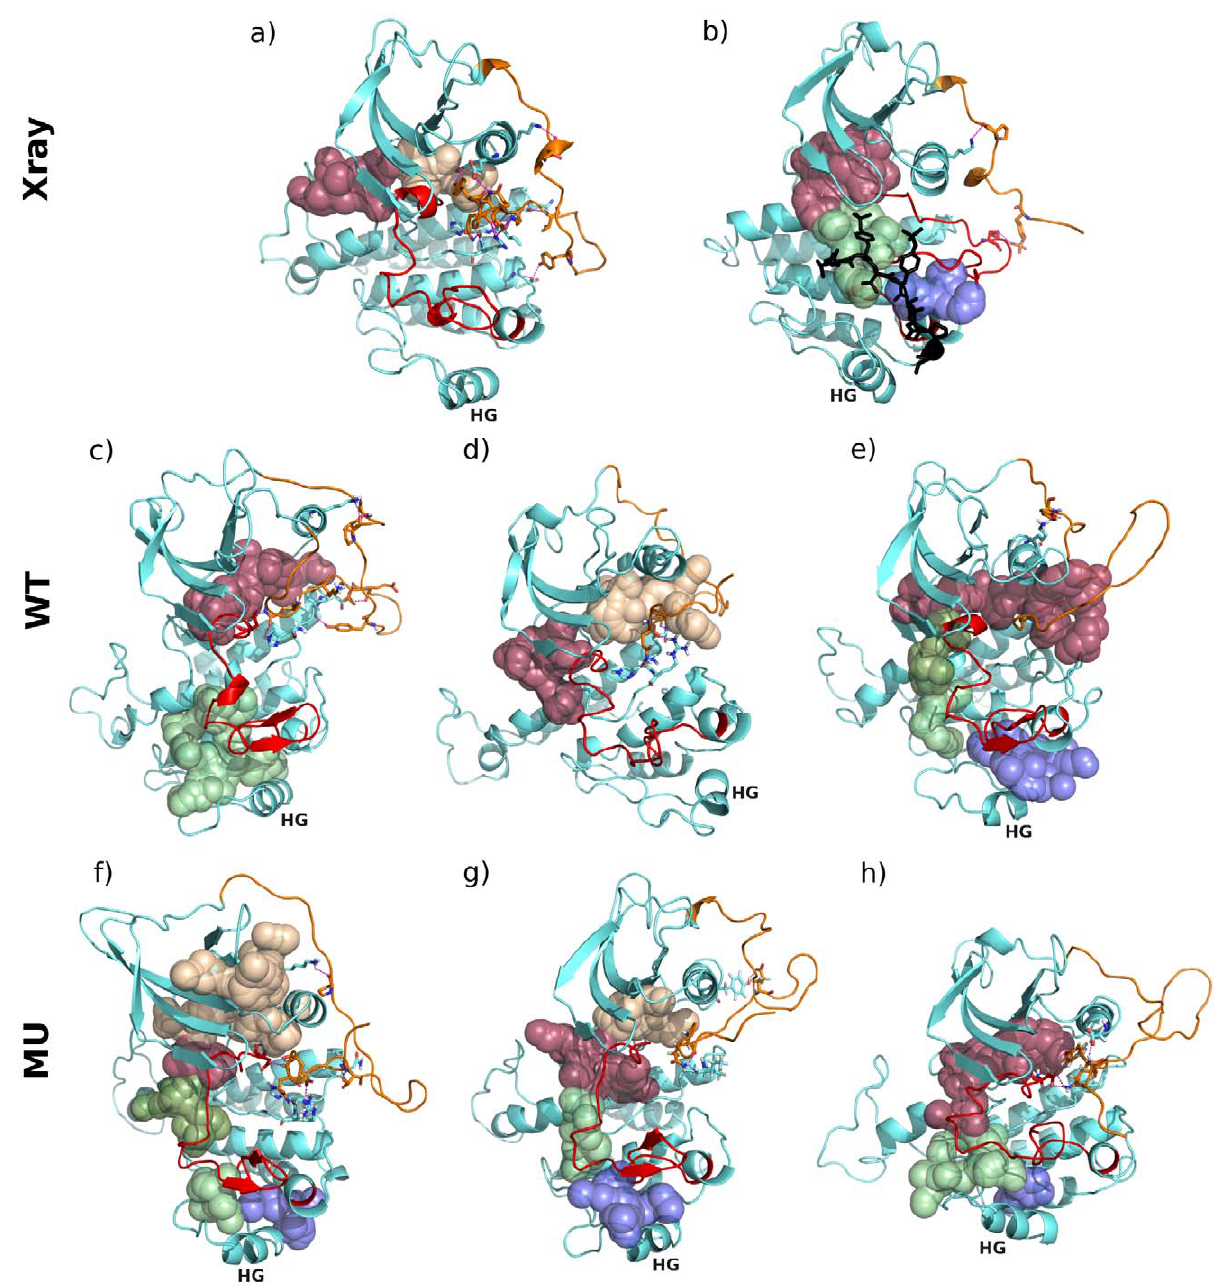
Figure 8. Pockets detected on the surface of wild-type and D816V-mutated KIT cytoplasmic region. Upper Panel: X-ray structures of KIT ( a ) in the inactive (auto-inhibited) form (1T45) and ( b ) in the active form (1PKG, chain A). Middle Panel: Conformations obtained from the 4-A˚ displacement of wild-type KIT along normal modes ( d ) 18 {42356-ps} , ( c ) 29 {34238-ps} and ( e ) 21 {49260-ps} . Lower Panel: Conformations obtained from the 4-A˚ displacement of D816V mutant along normal modes ( f ) 7 {30180-ps} , ( g ) 16 {30180-ps} and ( h ) 17 {2531-ps} . The core of the protein is in cyan, JMR is in orange, A-loop is in red and G-helix, which serves as a platform for the substrate in 1PKG, in labeled in black. The substrate is displayed in black cartoon and licorice on 1PKG structure ( b ). Residues involved in H-bonds between JMR and the PTK are drawn with sticks and the H-bonds are indicated by dashed purple lines. Pockets are displayed in red when they overlap with the catalytic site, in orange when they are located between the catalytic site and JMR, in olive, green or purple when they overlap with the substrate binding site.